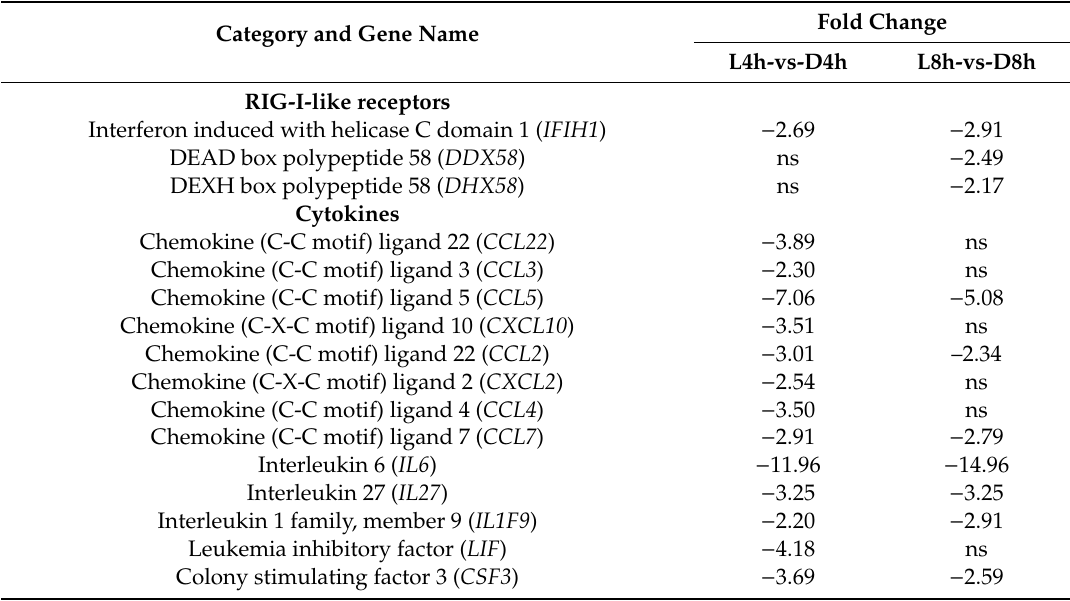
Table 3. Immune-related DEGs in L4h-vs-D4h and L8h-vs-D8h. The “-” symbol before the fold change number indicates downregulation. ns, not